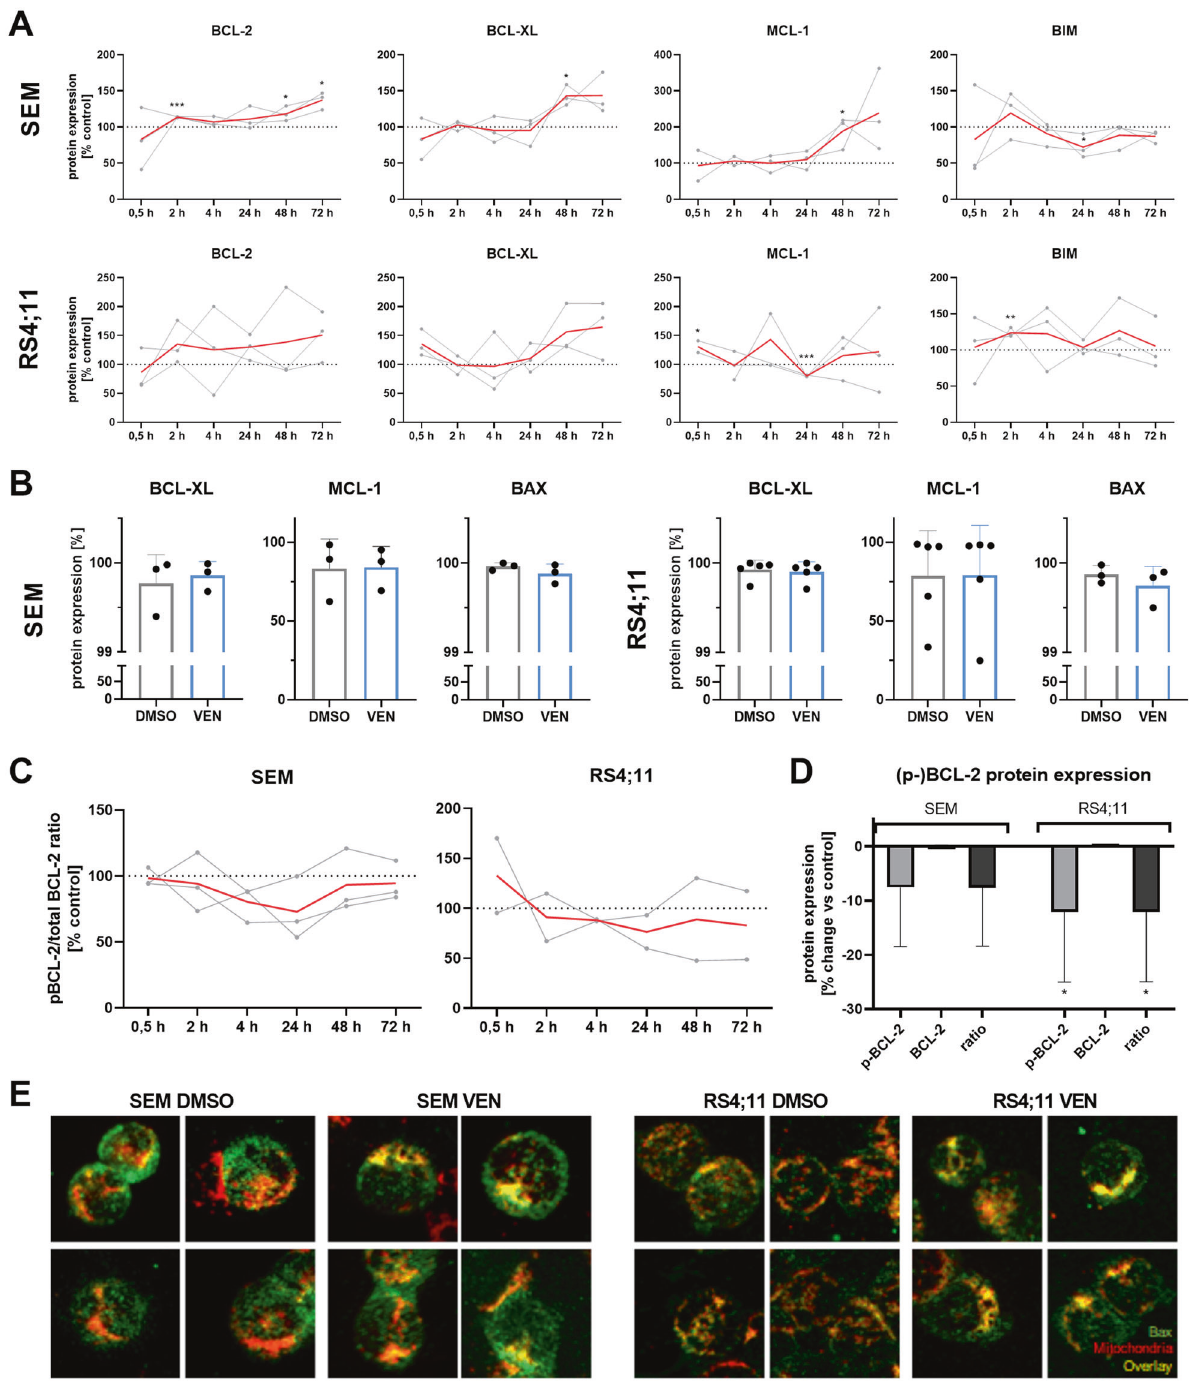
Fig. 3 Effect of VEN on BCL-2 pathway-mediated apoptotic signaling. A Expression of BCL-2 pathway proteins was assessed by immunoblot. Two to three individual biological replicates (gray) and expression mean (red); multiple t -tests, asterisks indicate signi fi cance vs time-matched DMSO control. B Total BCL-2 pathway member protein expression was analyzed by intracellular fl ow cytometry after 48 h incubation. Mean ± SD of three to fi ve biological replicates; ratio paired t -test. C The time-dependent in fl uence of VEN on BCL-2 phosphorylation was measured by immunoblot. BCL-2 and p-BCL-2 bands of three (SEM) or two (RS4;11) individual biological replicates were quanti fi ed. Relative BCL-2 phosphorylation values of all replicates (gray), as well as the mean of those experiments (red), are indicated in the graphs. Ratio paired t -test. D Protein expression of phosphorylated and total BCL-2 was assessed by intracellular fl ow cytometry after 48 h incubation with VEN or DMSO (control). Absolute expression values of controls was set to 100% and the relative change in protein expression following VEN incubation is indicated in the fi gure. Mean ± SD of fi ve (SEM) or four (RS4;11) biological replicates; paired t -test of each protein vs. respective control. E Functional assessment of Bax-mediated apoptosis induction was performed by Bax translocation assay after 48 h VEN incubation. Four representative images of four biological replicates per cell line and treatment group, 40-fold magni fi cation.